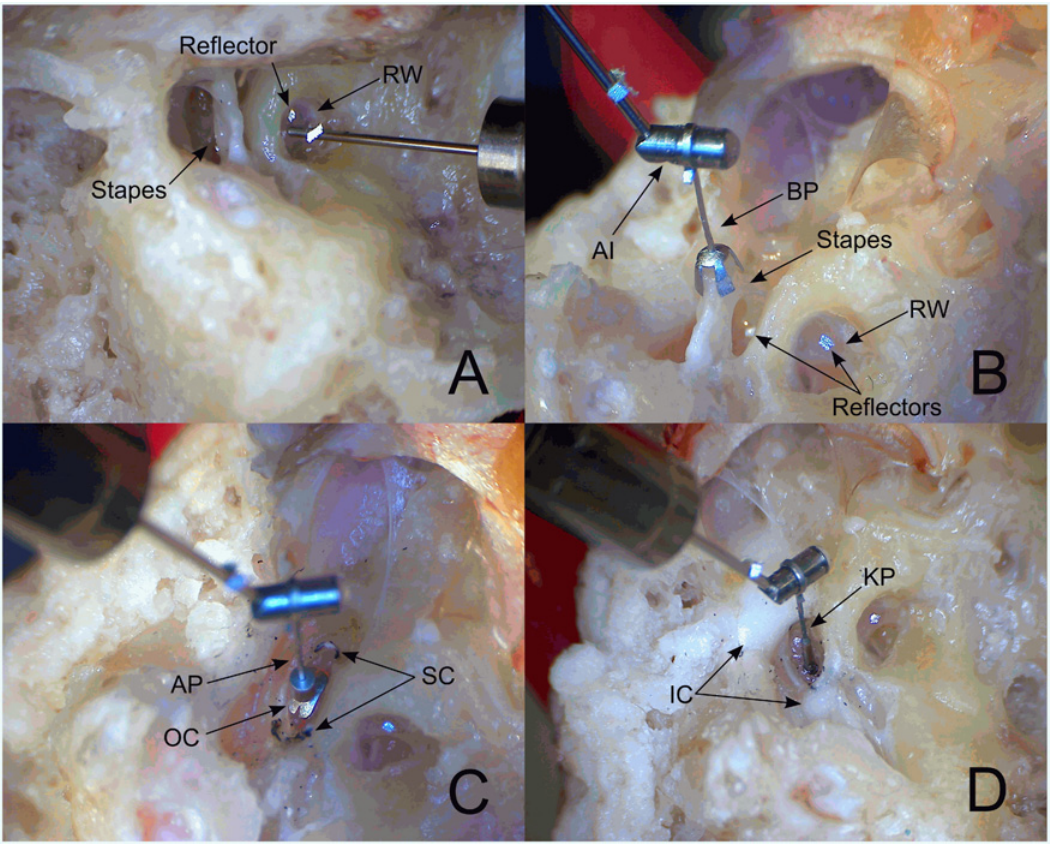
Fig 3. Stimulation modes tested. (A) Codacs actuator without AI perpendicular to the RW membrane. (B) Bell prosthesis (BP) crimped to the Codacs actuator AI and coupled to the exposed stapes head. Reflectors were placed on stapes footplate and round window (RW). (C) Omega connector (OC) placed between the remains of the stapes crura (SC) together with the Aerial prosthesis (AP) connected to the actuator AI. (D) K-piston (KP) inserted into the inner ear through a SFP fenestration after immobilization of the SFP by ionomer cement